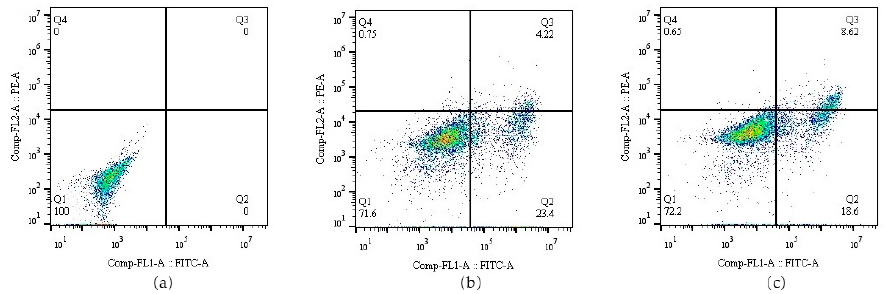
Figure 8. Flow cytometry chart representing the percentage of apoptotic HepG2 tumor cells treated with ( a ) PBS, ( b )A-BG-DOX (pH 6.5), and ( c ) free DOX (pH 6.5).